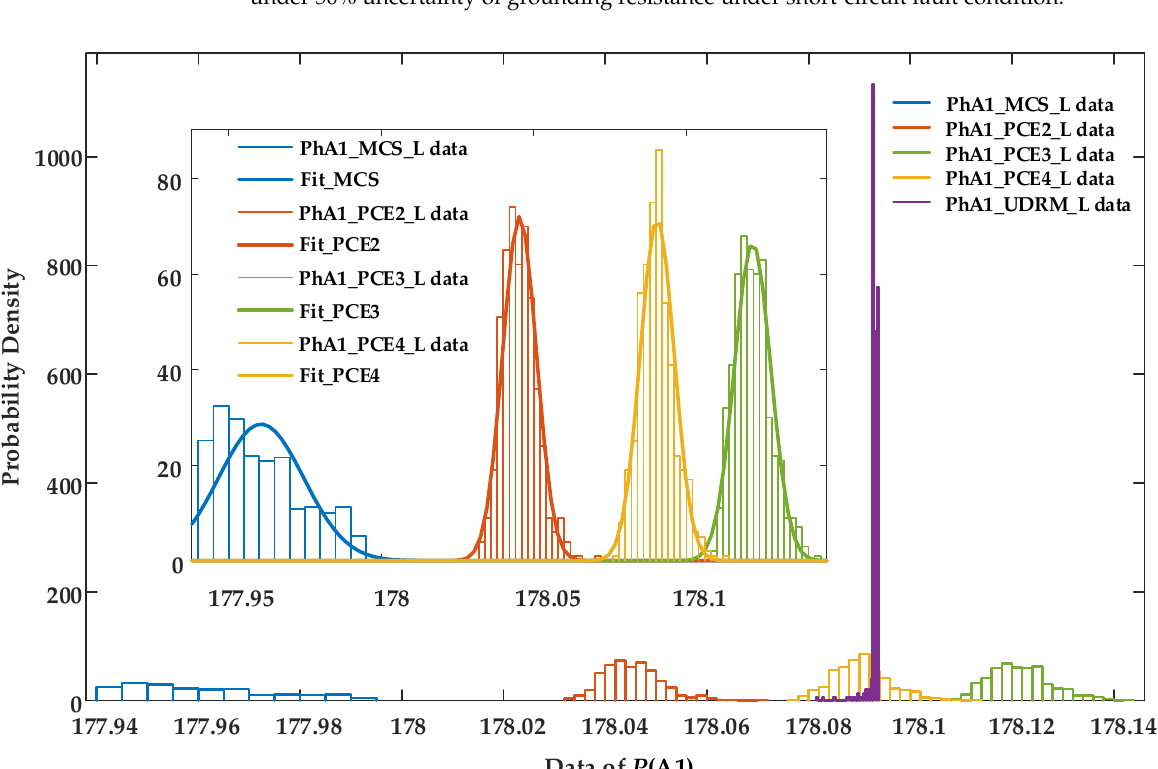
Figure 12. The probability density of the calculated data of P (A1) using the 5 different methods under 50% uncertainty of the cable length under short-circuit fault condition.